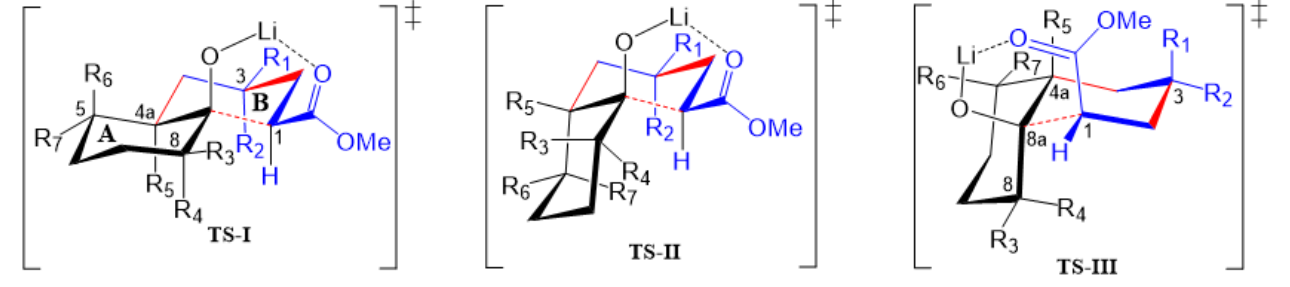
Figure 5. Transition states (TSs) proposed for the MIMIRC reaction between methyl acrylate and lithium enolate of substituted cycloalkanones. Substituent patterns will determine the stereochemistry of the obtained products.